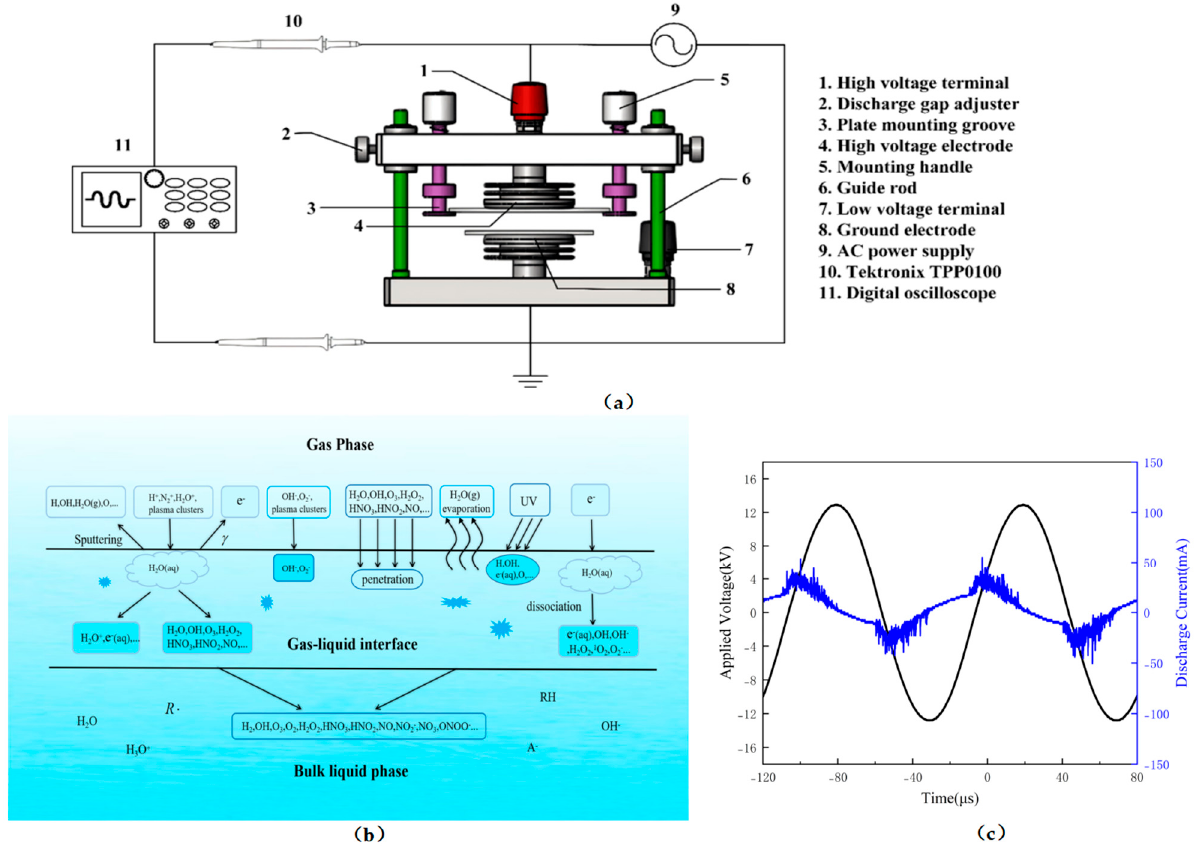
Figure 6. ( a ) Schematic diagram of experimental set-up for PAW generation; ( b ) chemical processes induced by DBD atmospheric cold plasma in gas–liquid interface; ( c ) typical discharge voltage and current